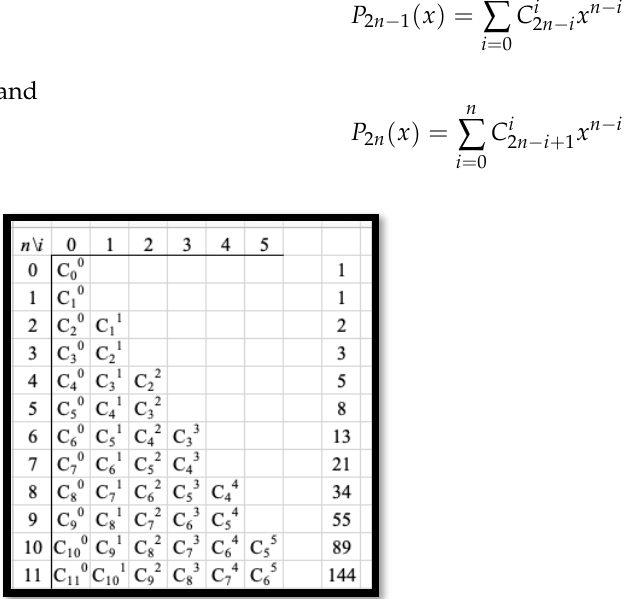
Figure 4. An alternative representation of the rearranged Pascal’s triangle.